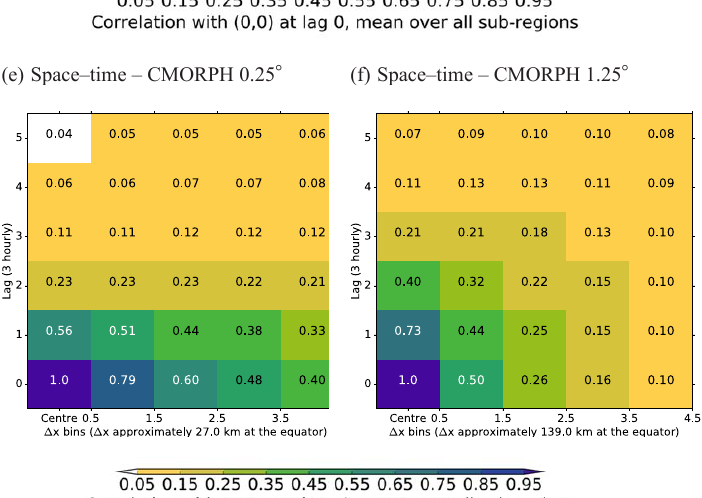
Figure 2. For CMORPH (a, c, e) 0.25 ◦ and (b, d, f) 1.25 ◦ data: (a, b) filled blocks show the 2-D histogram of binned values on consecutive 3h steps at the same gridpoint, aggregated over all gridpoints; the dashed line shows the 1-D histogram, using the right-hand axis; (c, d) the lag-0 correlation between each gridpoint in a 7 × 7 region and the central gridpoint (0,0), averaged over all non-overlapping 7 × 7 gridpoint regions in the domain; (e, f) lagged correlations between the central gridpoint in each 7 × 7 region and gridpoints within each range of distance on the horizontal axis away from the central point, averaged over all 7 × 7 regions. In (a, b) , note the logarithmic color scale; in (c–f) , the printed values and filled blocks show the same data. In (e, f) we omit the bin for points less than 0.5 (cid:49)x away from the central point, as no points in these datasets fall into that bin; “centre” is the auto-correlation at the central